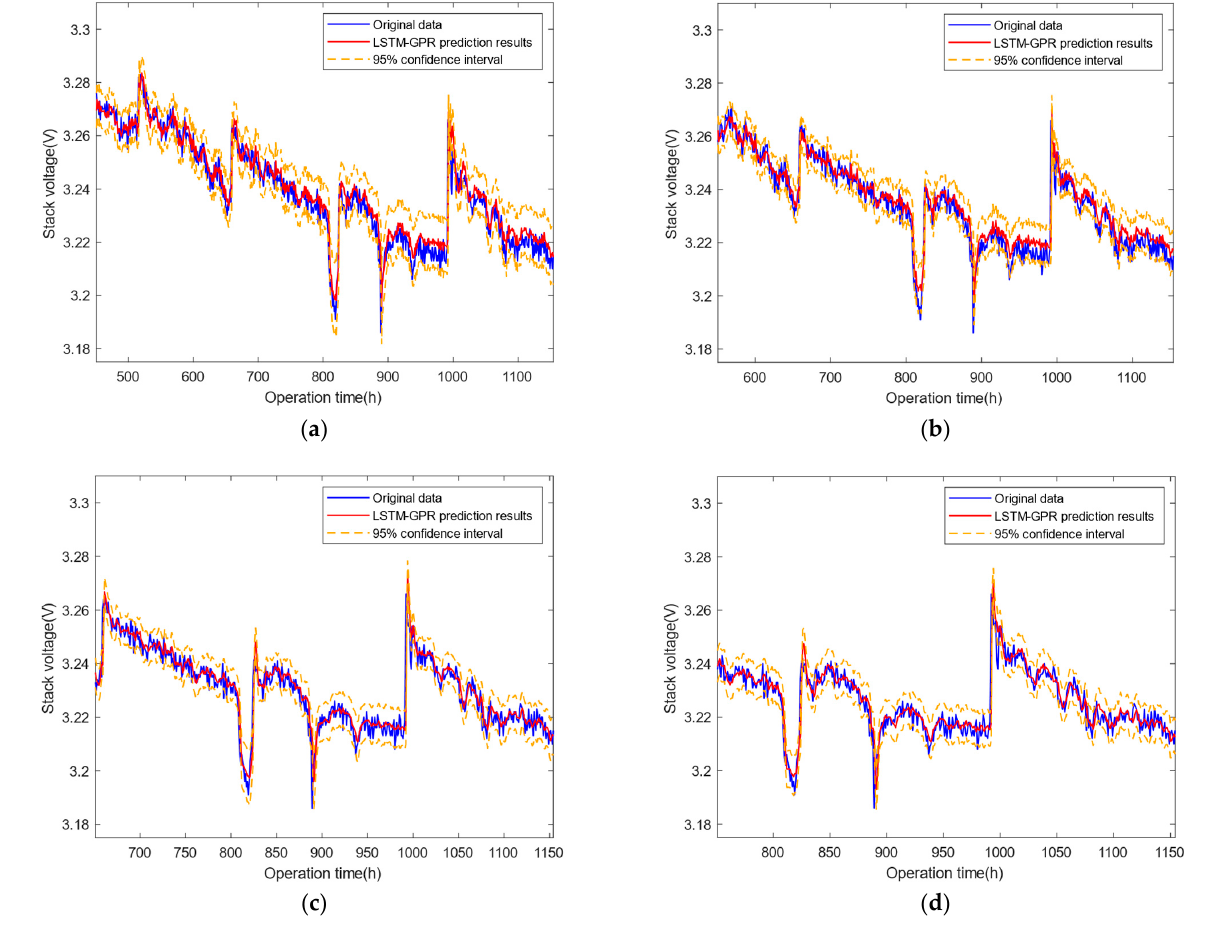
Figure 6. LSTM-GPR model prediction performance with TP at: ( a ) 450 h; ( b ) 550 h; ( c ) 650 h; and ( d ) 750 h.